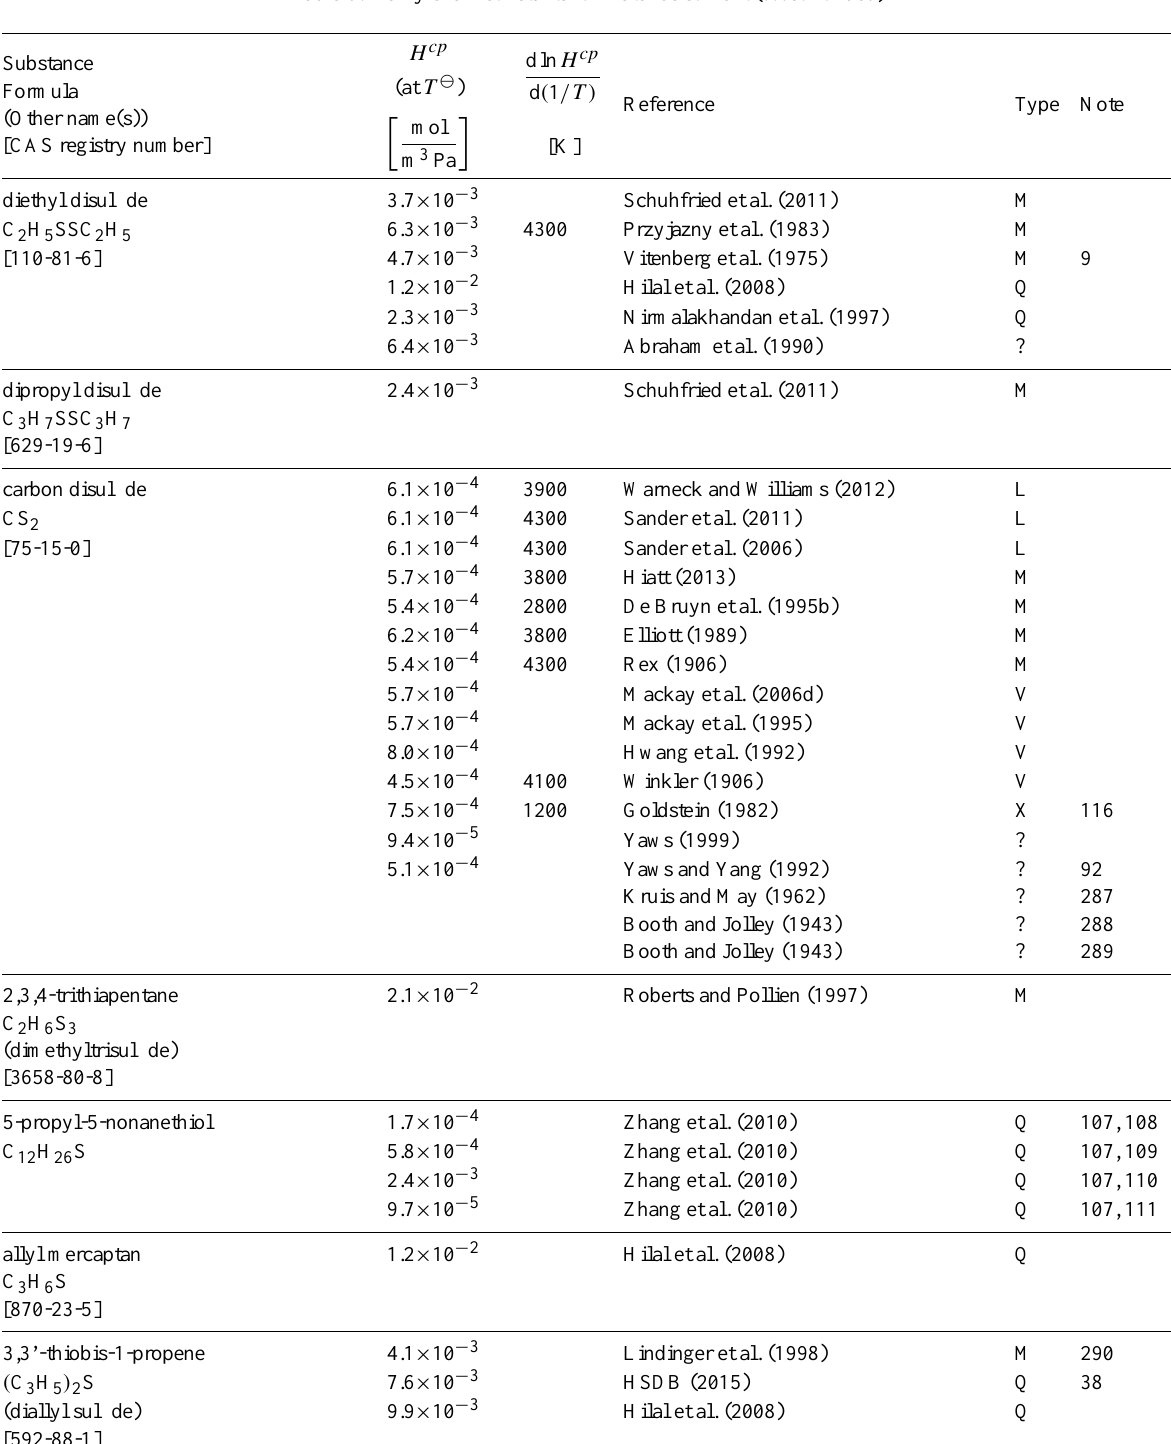
Table 6: Henry’s law constants for water as solvent